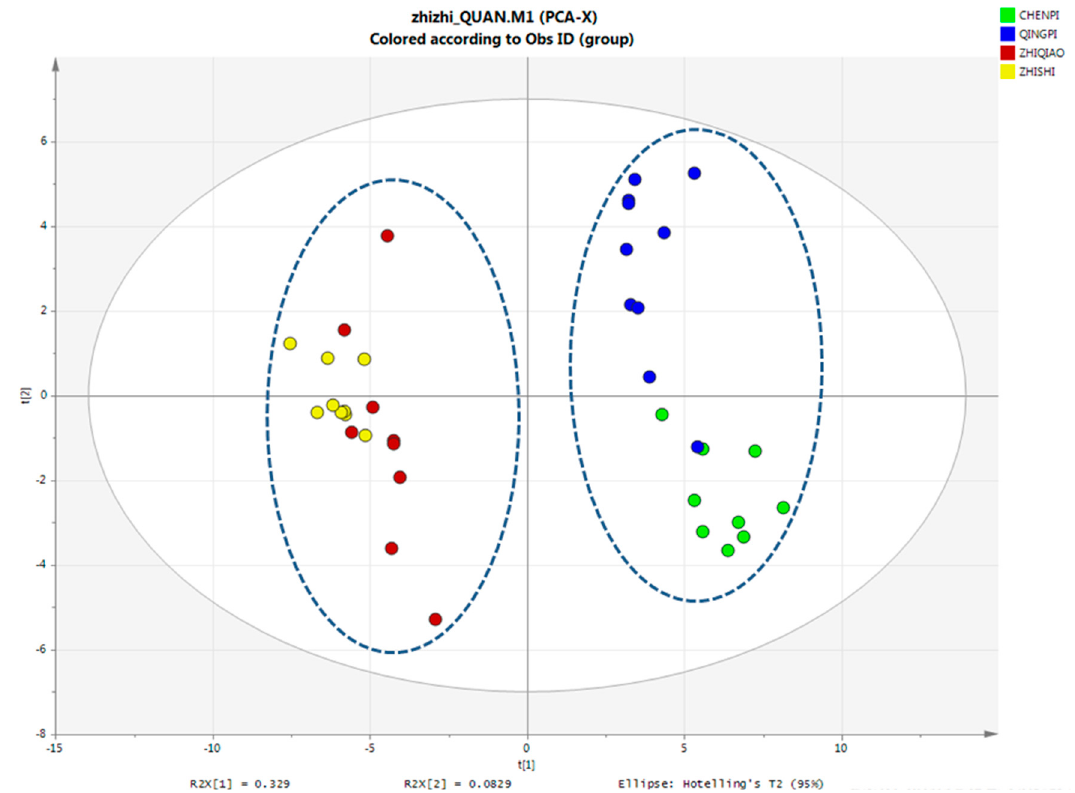
Figure 1. The PCA plot of primary metabolites using SIMCA (13.0 version). The data are UV scaled.